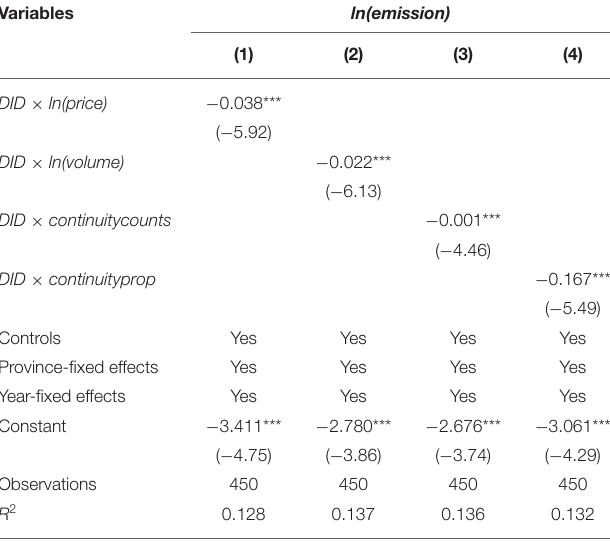
TABLE 8 | Effects by pilot market